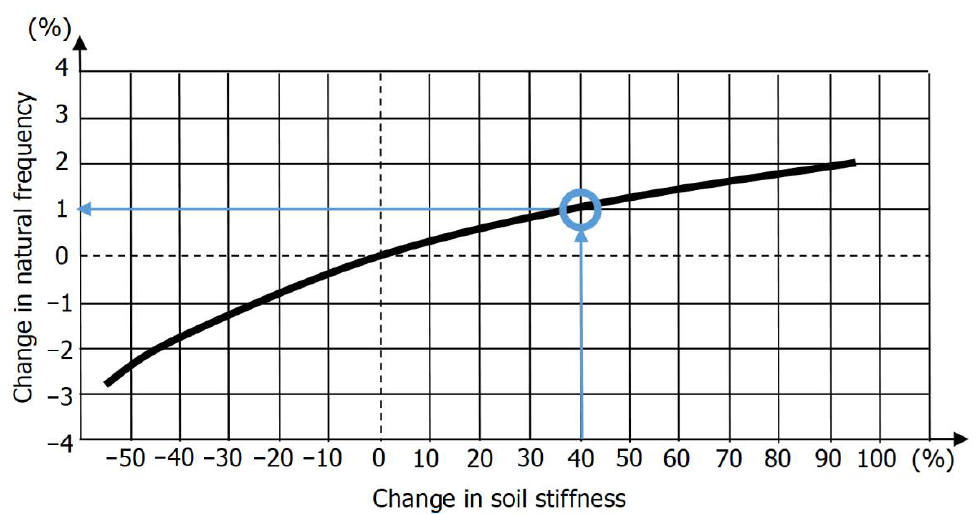
Figure 1. Natural frequency change due to change in soil stiffness during the lifetime of an offshore wind turbine with monopile foundation [35].